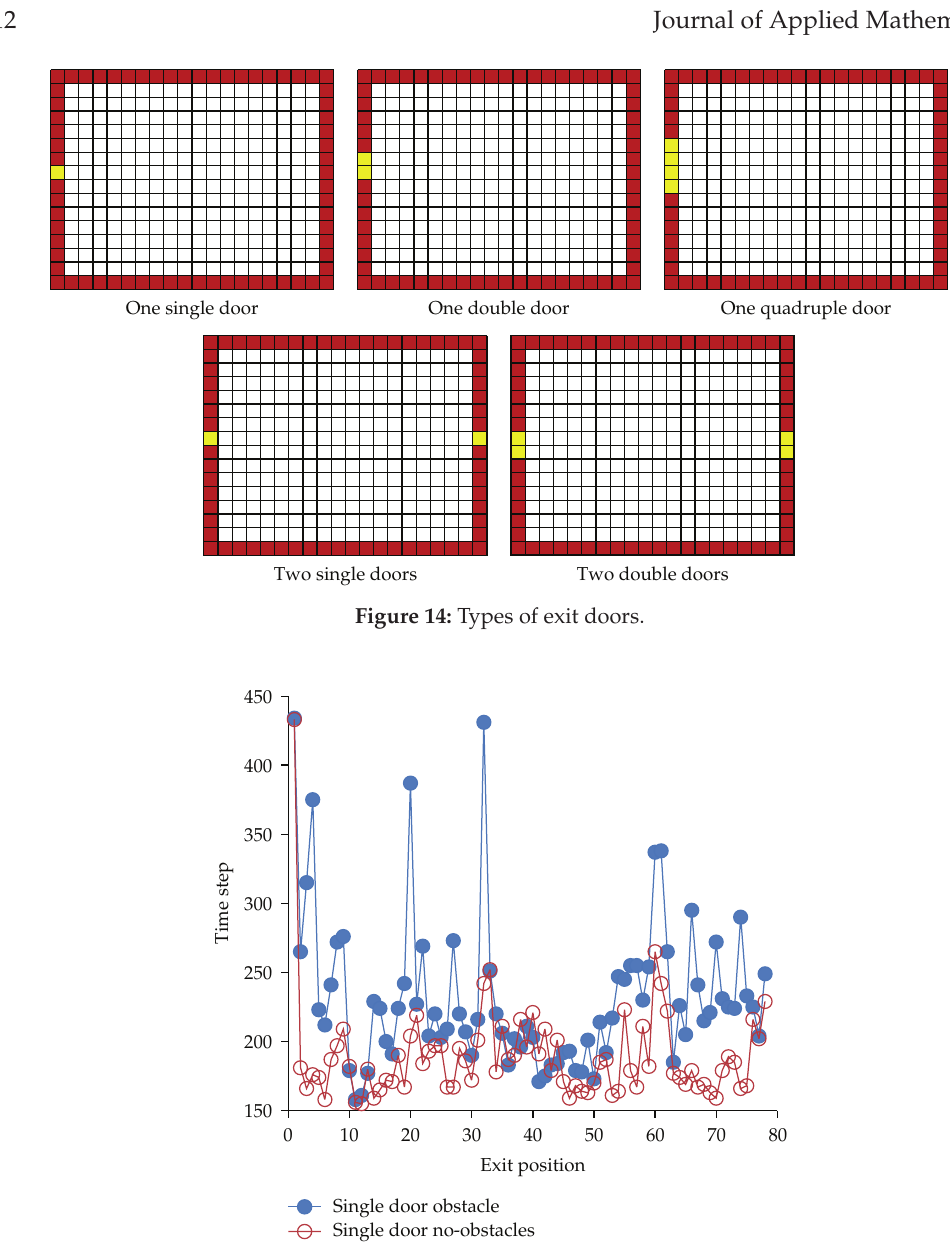
Figure 15: Evacuation time (cid:2) in time steps (cid:3) for 112 persons in the restaurant shown in Figure 12 with (cid:2) filled circles (cid:3) and without (cid:2) open circles (cid:3) obstacles for varying locations of one single-door exit (cid:2) average of 10 runs for each exit location (cid:3)